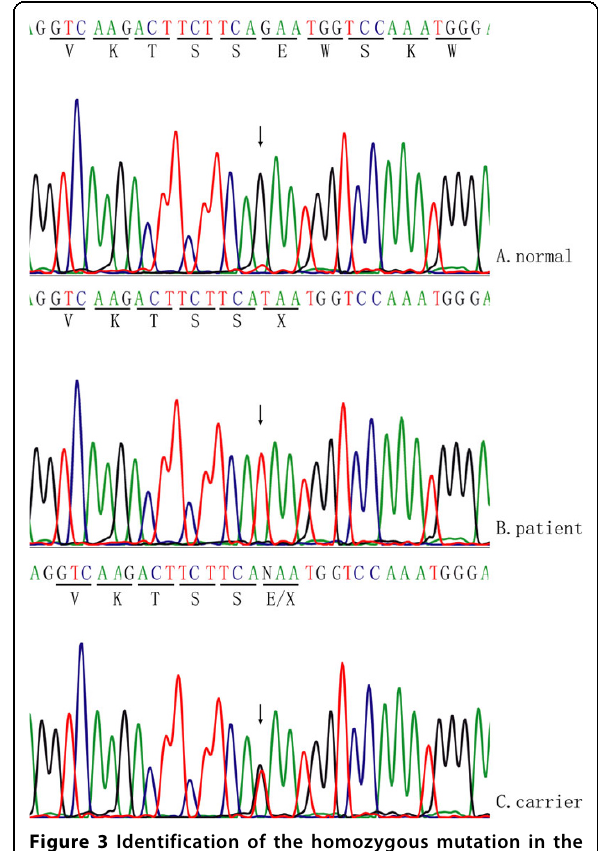
Figure 3 Identification of the homozygous mutation in the consanguineous Chinese arRP family . A and B show the exon 26 of EYS sequences from a normal individual and an affected individual with p.E1836X mutation, respectively. The sequence for individual III1, who is heterozygous for the mutation, is shown in